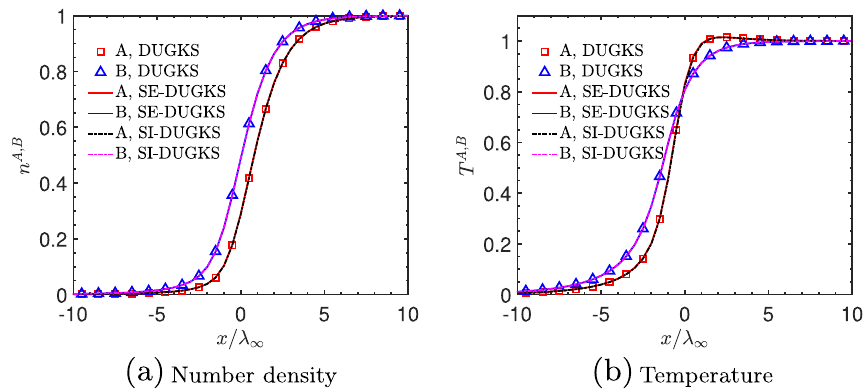
Fig. 6 Shock structure with Ma − = 3.0 , m B ∕ m A = 0.5 , and 𝜒 A =